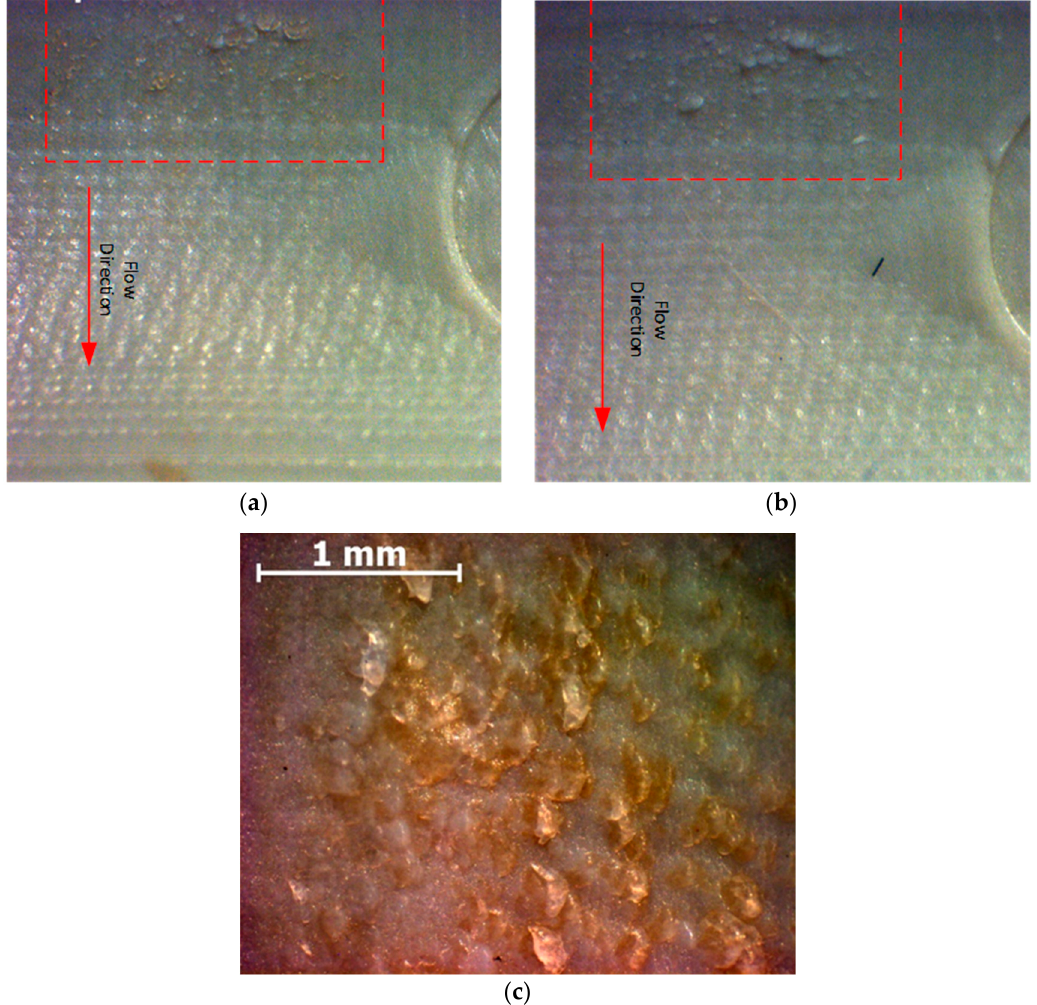
Figure 6. ( a ) Tool material eroded and deposited on the seventh shot from the tool. ( b ) Protrusions on the eighth part, due to surface deterioration of the tool in the same vicinity. ( c ) Magnified image of the area of the eroded tool surface.